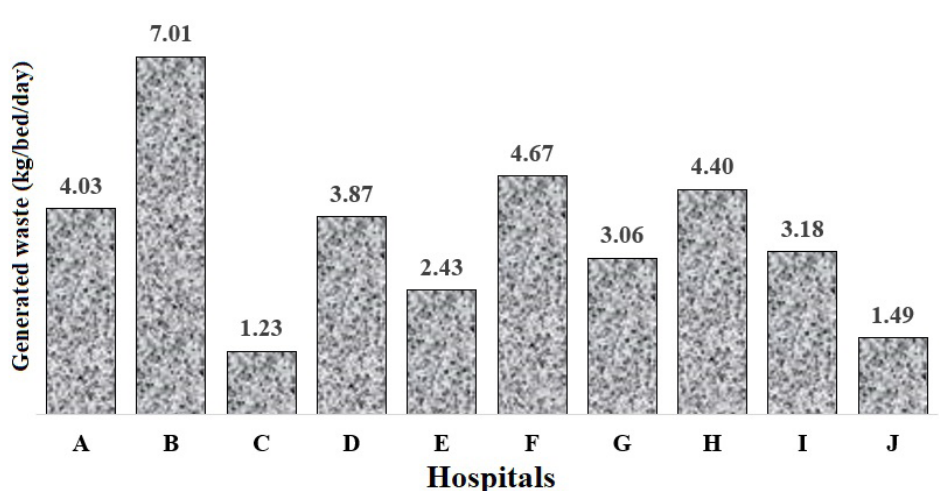
Figure 1. Medical waste generation in the hospitals studied (kg/bed/day)